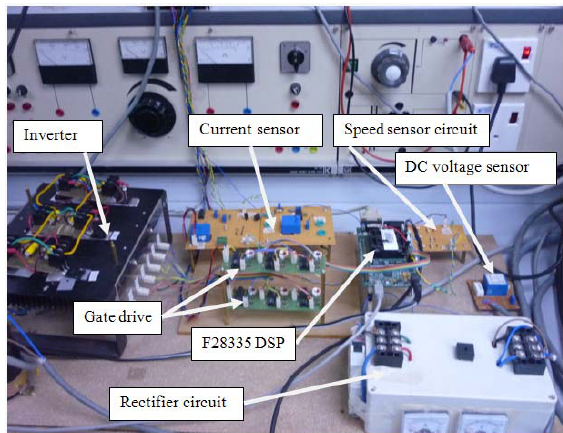
Figure 13. Circuits of the induction motor